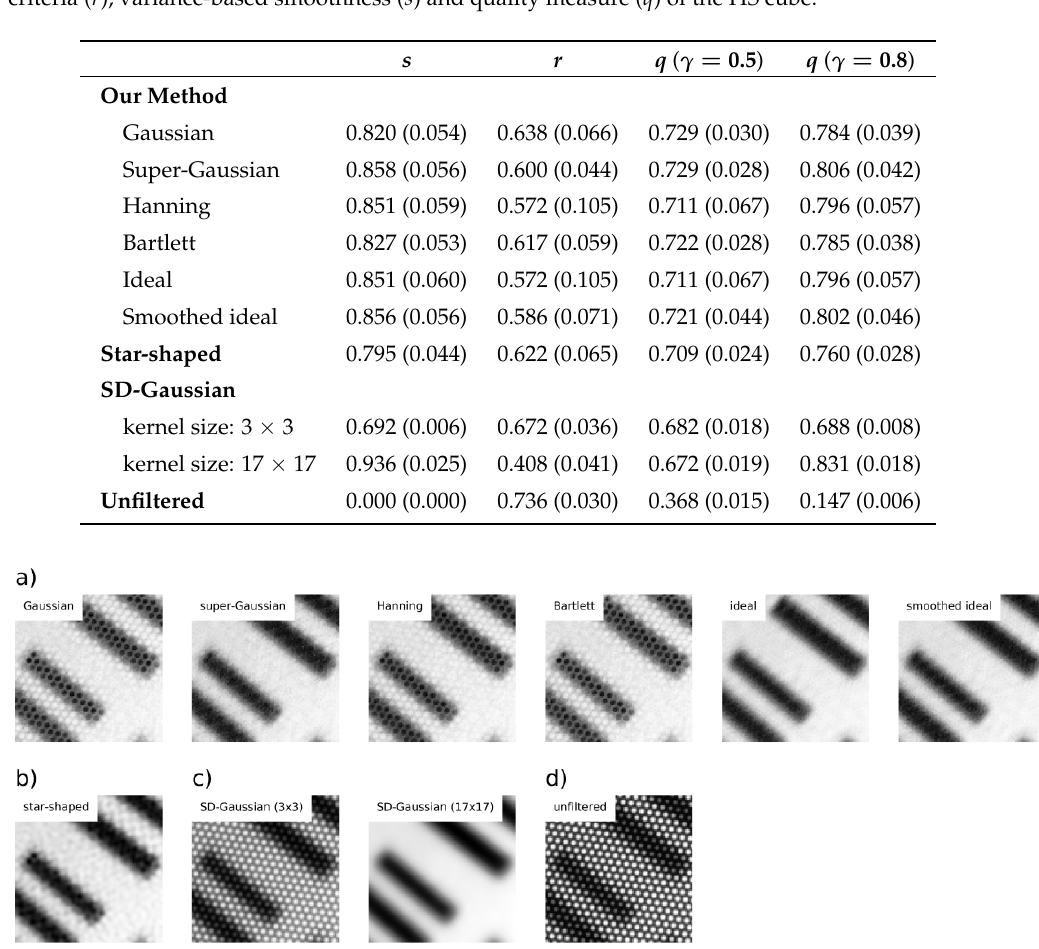
Table 1. Comparison of our method using various filters to spatial domain (SD)-Gaussian filtering and star-shaped filtering to remove the honeycomb-like pattern from the United States Air Force (USAF) test chart. Mean and standard deviation are listed for quality metrics Rayleigh-based line separation criteria ( r ), variance-based smoothness ( s ) and quality measure ( q ) of the HS cube.